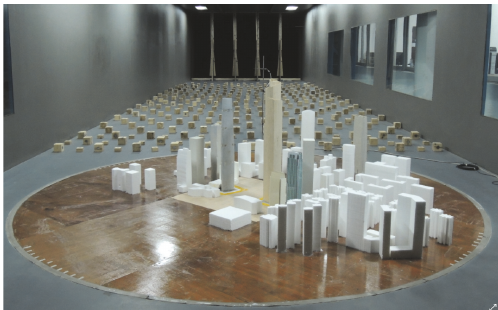
Figure 5: The model of Guangzhou East Tower (GZET) in wind tunnel test.